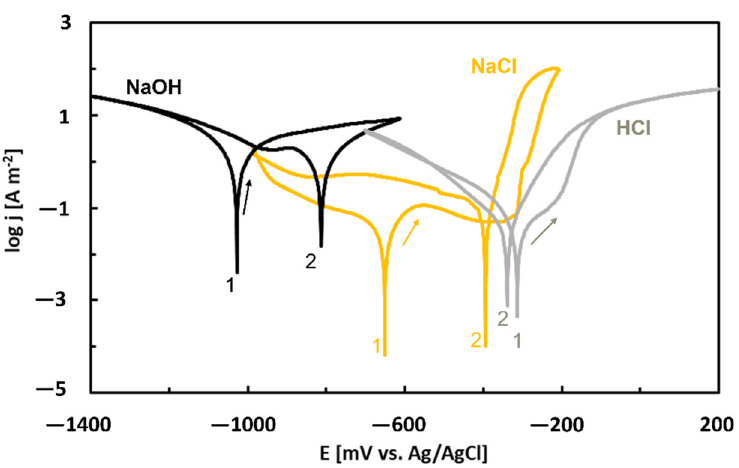
Figure 12. Potentiodynamic cyclic polarization curves of near-equilibrium Al 74 Co 26 alloy in different electrolytes, re-plotted from reference [86].